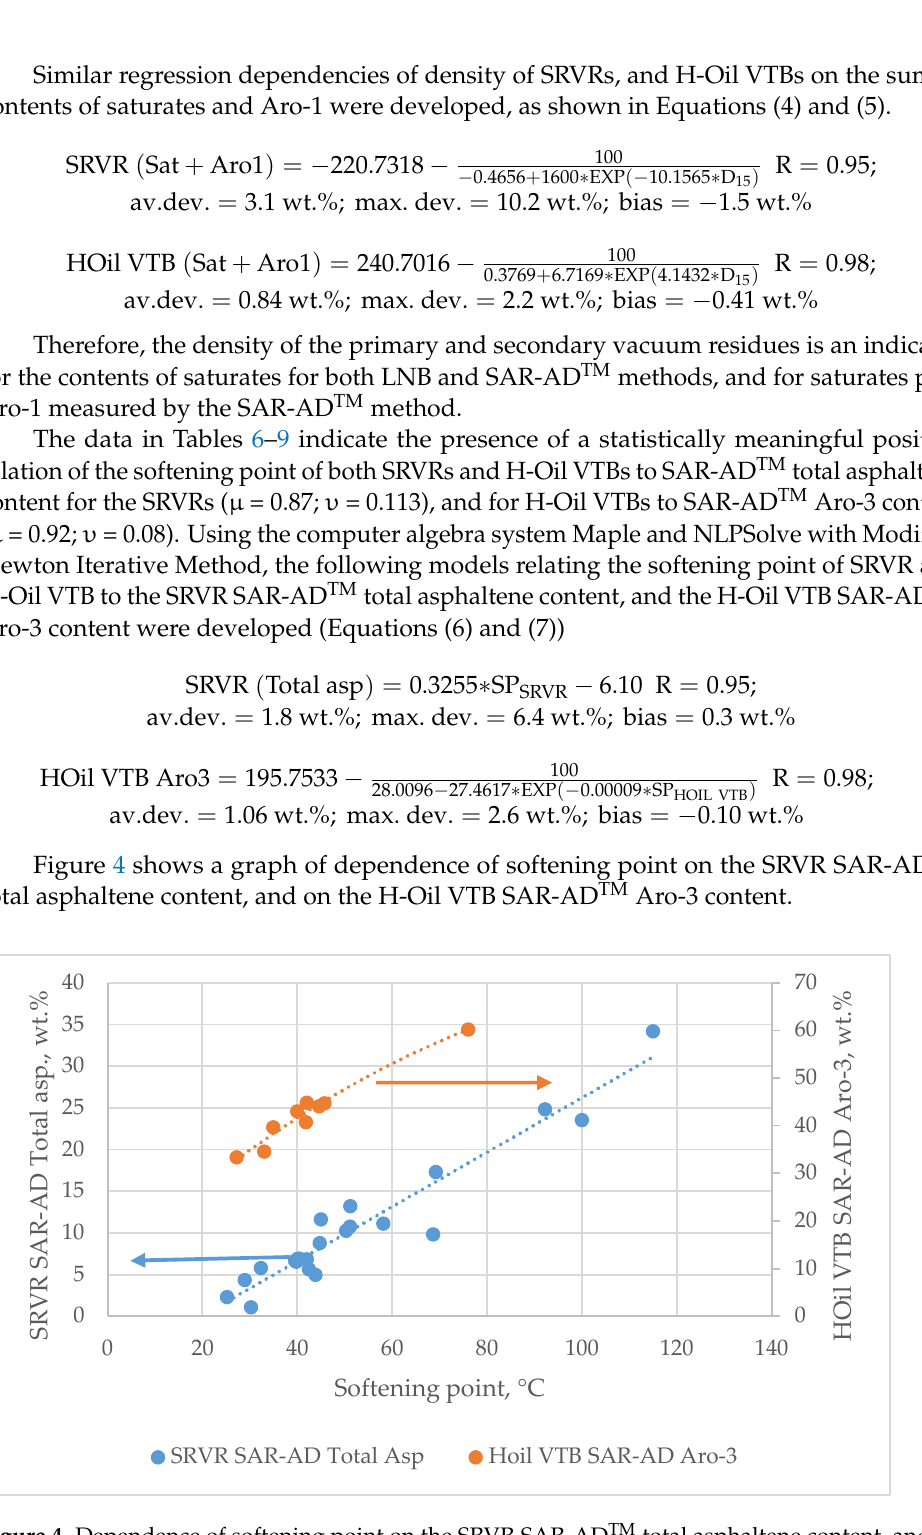
Figure 4. Dependence of softening point on the SRVR SAR-AD TM total asphaltene content, and on the H-Oil VTB SAR-AD TM Aro-3 content. (The orange arrow means that this data is referred to the right hand ordinate. The blue arrow implies that this data is referred to the left hand ordinate.)